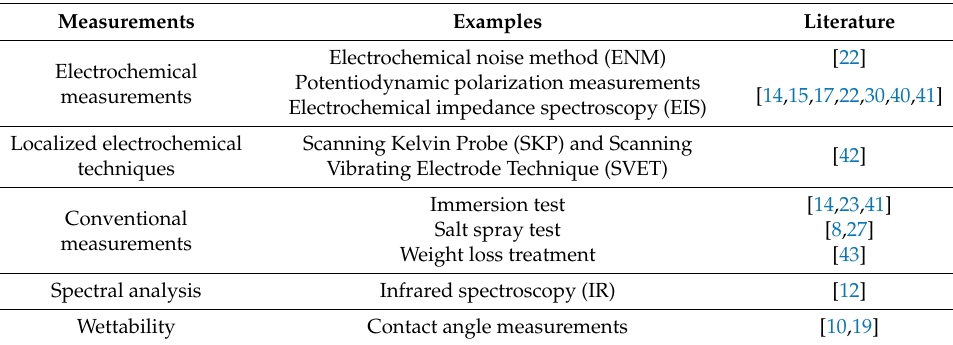
Table 4. Common methods for corrosion measurements.